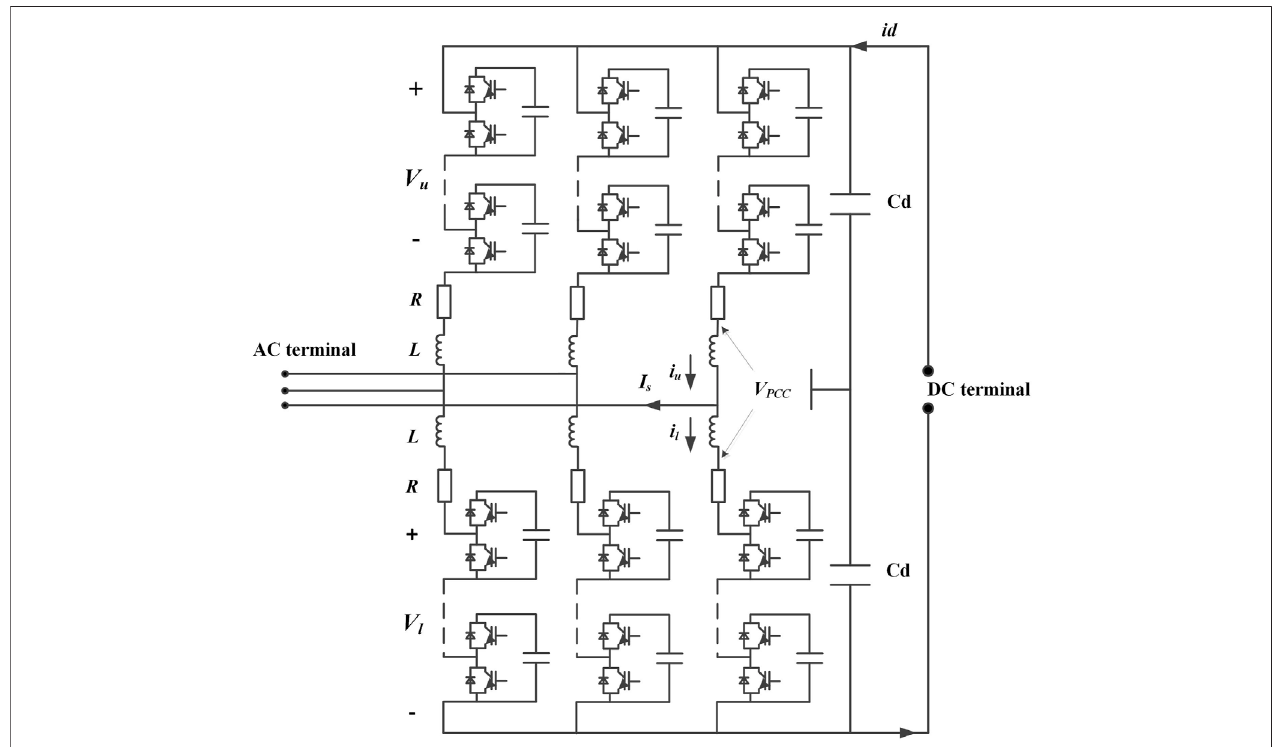
FIGURE 2 | Circuit